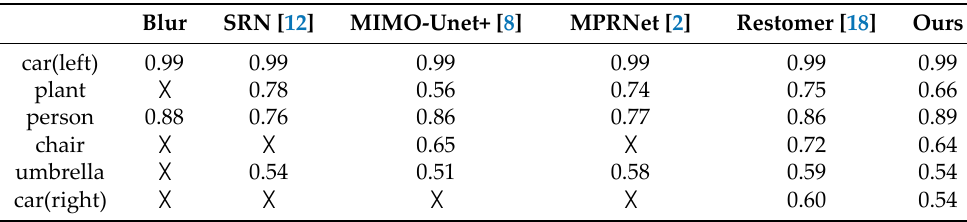
Figure 9. The visual example of object detection. From top left to bottom right: blurry images, the restoration of SRN [12], MPRNet [2], MIMO-Unet+ [8], Restomer [18], and our model. Table 4. The detection evaluation result of each object. “ ☓ ” means this object cannot be detected in the restoration of the current deblurring model.